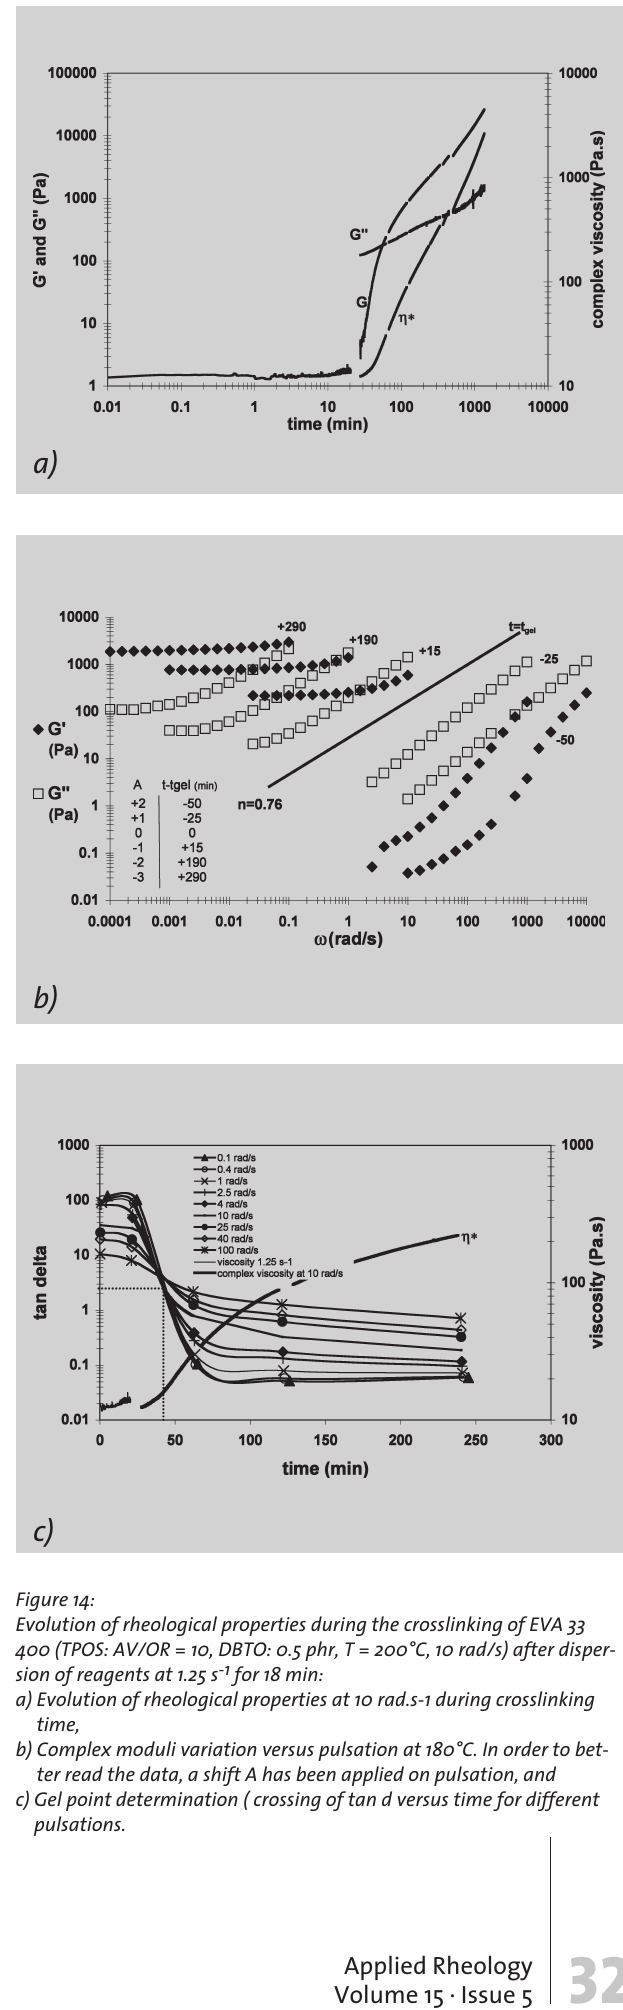
Figure 14: Evolution of rheological properties during the crosslinking of EVA 33 400 (TPOS: AV/OR = 10, DBTO: 0.5 phr, T = 200°C, 10 rad/s) after disper- sion of reagents at 1.25 s -1 for 18 min: a) Evolution of rheological properties at 10 rad.s-1 during crosslinking time, b) Complex moduli variation versus pulsation at 180°C. In order to bet- ter read the data, a shift A has been applied on pulsation, and c) Gel point determination ( crossing of tan d versus time for different